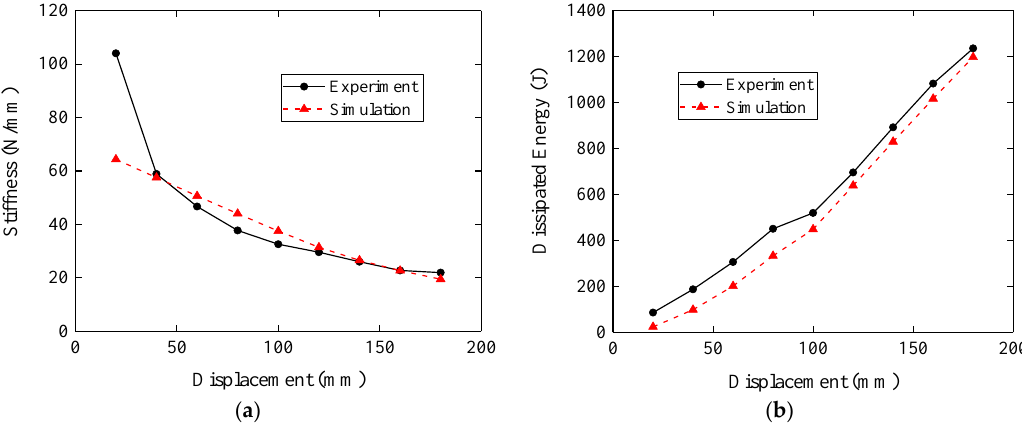
Figure 9. Results from the experiment and the simulation: ( a ) Stiffness; ( b ) dissipated energy.